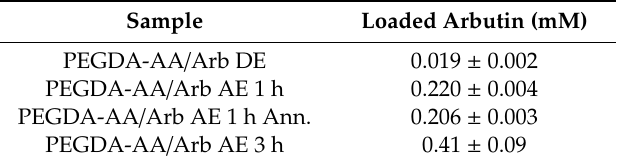
Table 2. Arbutin loading onto the prepared coatings, evaluated by